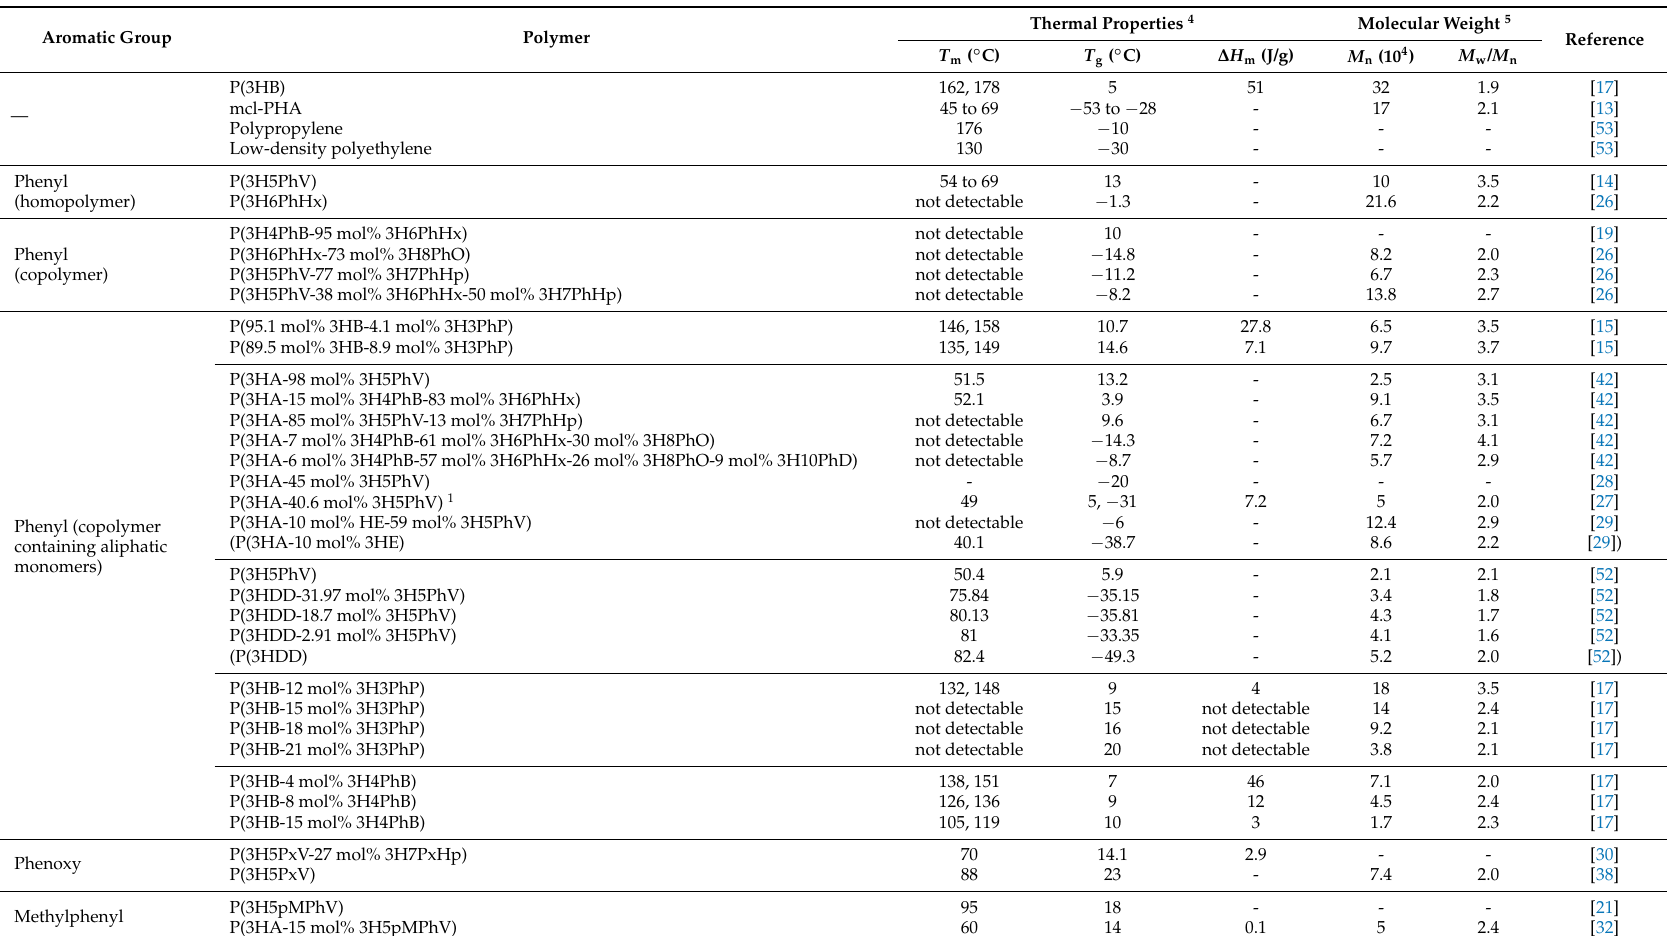
Table 3. Thermal properties of aromatic